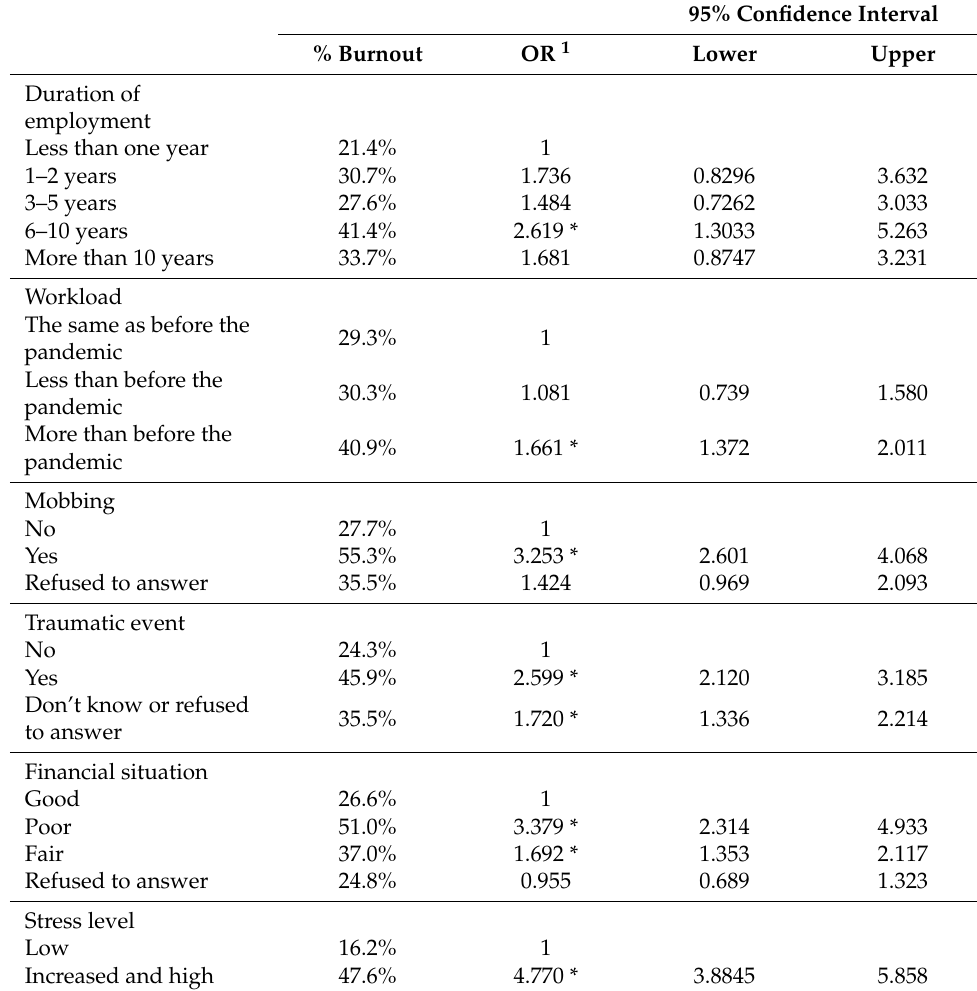
Table 5. Prevalence of burnout by selected characteristics and the risk for burnout based on results of logistic regression analysis adjusted for gender and professional group (N =